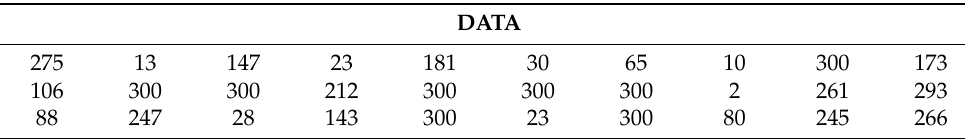
Table 4. Meeker and Escobar Data of 30 Devices.